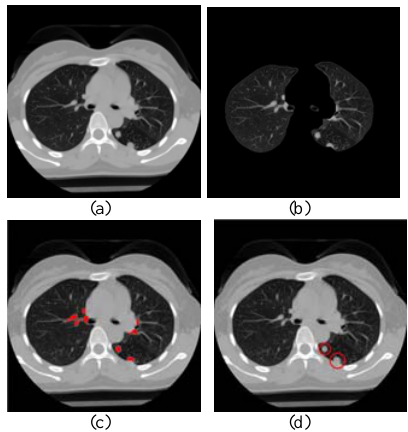
Fig. 13. Recognition results of the case containing a ground- glass opacity nodule. (a) CT original image, (b)Lung parenchyma segmentation, (c) ROIs extraction, (d) Classification results.